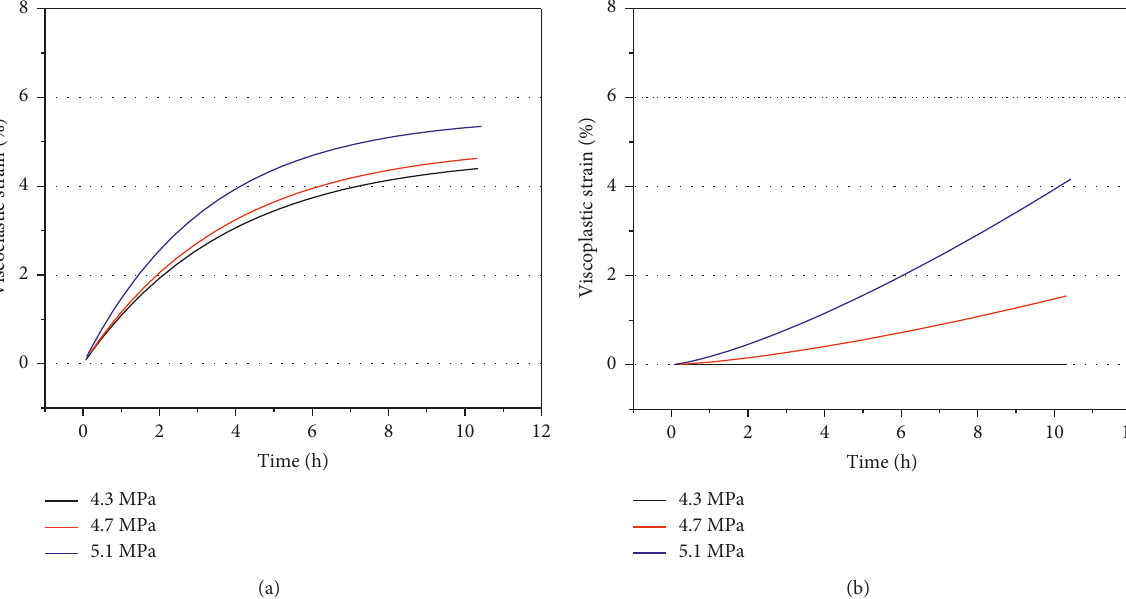
Figure 17: Viscoelastic and viscoplastic deformation of the frozen, deep clay (10MPa-7d): (a) viscoelastic strain and (b) viscoplastic